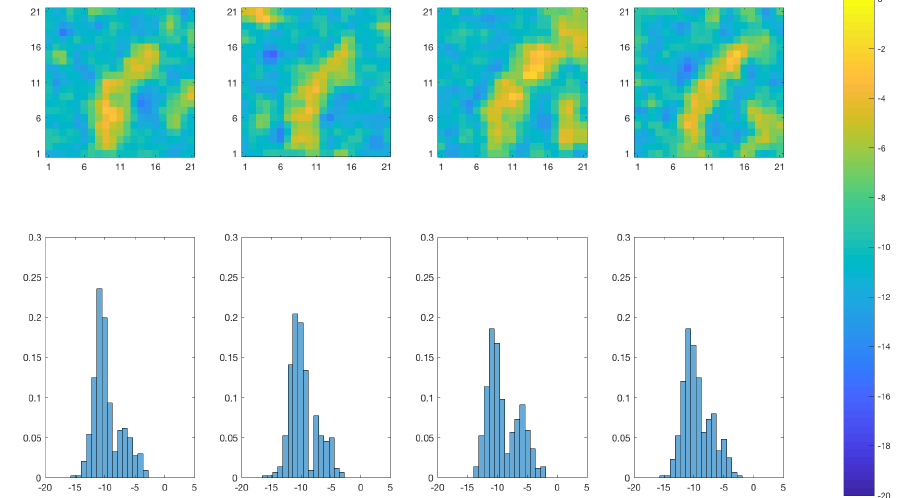
Figure 10. SEnKF approach: Realizations of the posterior distribution of the log diffusivity f ( log ( λ ) | d 0: T ) at time T = 100 ( upper panels) and associated spatial histogram ( lower panels). Lower panels: the horizontal axes represent the log-diffusivity, the vertical axes represent the relative prevalence of each log-diffusivity value for the realization in the panel right